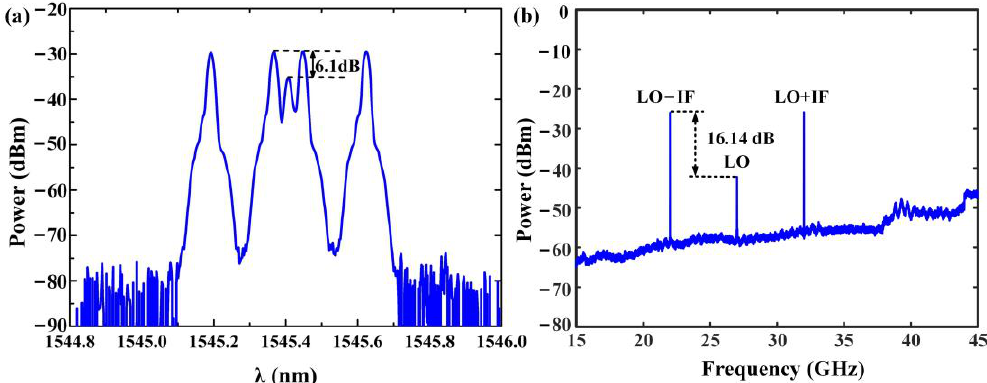
Figure 2. Measurement results for converting a single-tone IF signal at 5 GHz to 22 GHz and 32 GHz by using an LO signal at 27 GHz. ( a ) Optical spectrum from the DP-DPMZM. ( b ) Electrical spectrum of the output signal after frequency mixing.